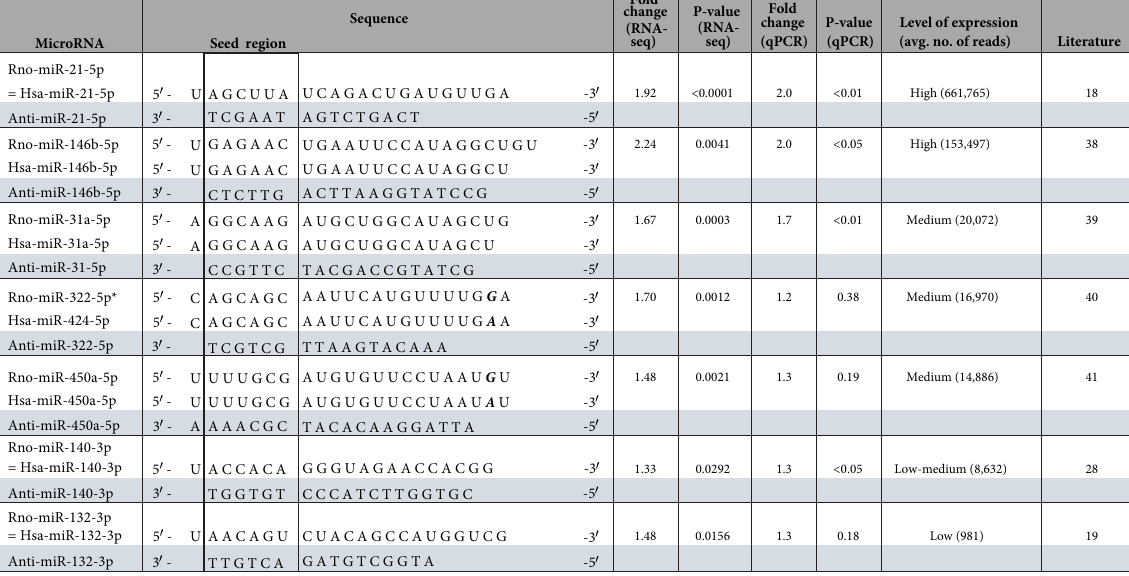
which without pretreatment resulted in a 28% lower force. While – as expected from our previous results and the literature – anti-miR-21-5p and anti-miR-132-3p partially prevented this decline, no effect could be observed for anti-miR-146b-5p, anti-miR-322-5p and anti-miR-450a-5p, and we even observed an adverse effect of anti-miR- 31a-5p. However, anti-miR-140-3p pretreatment was inclined to prevent the AE-induced contractile decline to a similar extent as anti-miR-21-5p and anti-miR-132-3p (Fig. 3). Shortening of anti-miR-140-3p to facilitate future in vivo applications. The LNA-anti-miR-140-3p we used in the small-range screen was 19 nucleotides long. Apart from one nucleotide both at the 5 ′ -end and at the 3 ′ -end, it covered the entire miR-140-3p sequence including the seed region. While this design leads to a reliable inhibition of target microRNAs when transfected in vitro (all microRNAs in Fig. 2 were targeted like that), its main disadvantage is that it cannot be taken up into cells unassisted. In contrast, slightly shorter ( ≤ 15 nucleotides) anti-miRs are well taken up by cells, rendering in vivo experiments possible 21 . We designed four shorter anti-miRs targeting miR-140-3p (S1–S4), each consisting of 14 or 15 nucle- otides (Table 2). To counteract the decrease in binding affinity by shortening of the anti-miRs, we increased their relative LNA content from 26% to over 33%, which limited the drop in melting temperature to few degrees. Yet, the shorter anti-miRs S1-S3 were less efficient than the longer version, and only when two 5-carbon-methylated-cytosin-LNAs (5-Me-C-LNAs) were included (in anti-miR-140-3p-S4) an inhibition of miR-140-3p of > 90% could be reached (Fig. 4a). All Anti-miR-140-3p-versions were tested with the same exper- imental procedure (Fig. 1a, i.e. transfection at 100 nM) as for the small-range screen. In contrast to the long anti-miR, which exerted a trend of a protective effect (Fig. 4b), the less effective shorter anti-miRs S1 (Fig. 4c), S2 (Fig. 4d) and S3 (Fig. 4e) did not protect against the AE-induced contractile failure. In contrast, the highly effective (94% inhibition) anti-miR-140-3p-S4 almost halved ( − 46%) the detrimental effect of AE (Fig. 4f). Taken data from all four inhibitors together, we found a significant negative correlation between unbound miR-140-3p concentration and contractile force of AE-EHTs (Fig. S3). Further characterization of miR-140-3p inhibition in AE-EHTs. The inhibitor anti-miR-140-3p-S4 was very effective and had a beneficial effect on contractile force, so we went on to further evaluate its effects on AE-EHTs. The changes of contraction kinetics due to AE included a tendency towards a prolonged relaxation time ( + 19%), which was less pronounced under miR-140 inhibition (Fig. 5a), as well as a significant reduction of relaxation velocity, which was partly prevented by anti-miR-140-3p pretreatment (Fig. 5b). As the hallmark of cardiac hypertrophy we also measured cardiomyocyte size from dystrophin-stained EHT cross sections (Fig. 5c) and found hypertrophied cells in AE-EHTs (76 µ m 2 on average) compared to control EHTs (58 µ m 2 on average). The mean cell size in anti-miR-140 pretreated EHTs was 70 µ m 2 and thereby in between the two other groups, yet not significantly different from AE-EHTs (Fig. 5d). Additionally we stained EHTs for atrial natriuretic peptide (ANP; Fig. 5e) and found a 5-fold increase in ANP-positive area per EHT cross section in AE-EHTs compared to controls (1.40% vs 0.28%) and an even larger area under miR-140 inhibition (2.6%; Fig. 5f). However, both groups did not differ statistically significantly from the control. Gene expression of other markers for patholog- ical hypertrophy was analyzed using quantitative PCR, but no major effect of miR-140-3p inhibition could be observed (Fig. S4a).